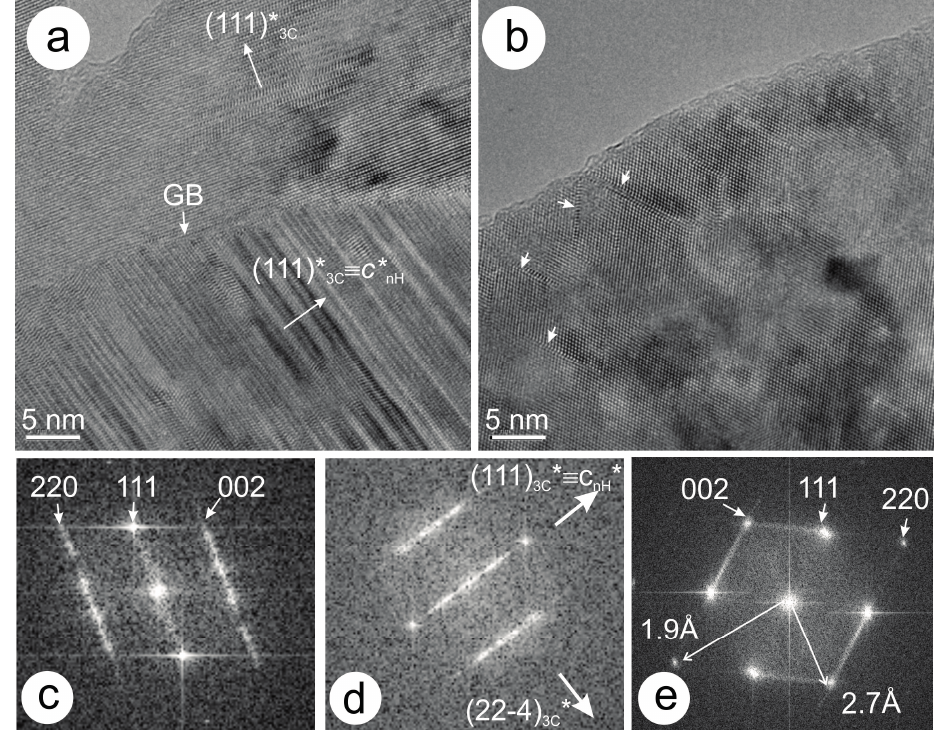
Figure 5. High Resolution Transmission Electron Microscopy (HRTEM) images of Ge-Fe-rich sphalerite showing ( a ) an irregular boundary (GB) separating grains of different orientation, i.e. , (111)* 3C at 75° to one another. Note sets of irregular [1–10] twins expressed by contrast differences on the lower grain; ( b ) 3C sphalerite down the same zone axis showing abundant stacking faults along (hkl)* directions (arrowed). Images recorded using a JEOL 2011 instrument (JEOL Co. Ltd., Akishima, Japan) at the Monash Centre for Electron Microscopy, operated at 200 kV. ( c – e ) Fast Fourier Transform diffractions computed from images in ( a ) and ( b ), showing orientations of upper and lower grains in ( a ) as ( c ) and ( d ), and of the grain from ( b ) in ( e